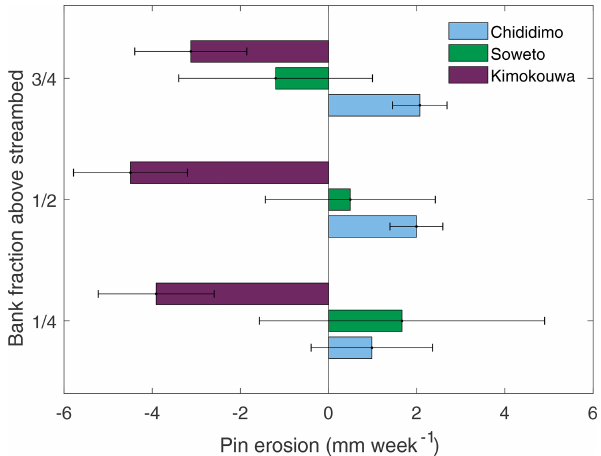
Figure 7. Cumulative bank change over the duration of measure- ment at each sand dam for the upstream and downstream pinned banks. A positive value signifies deposition, a negative value ero- sion.